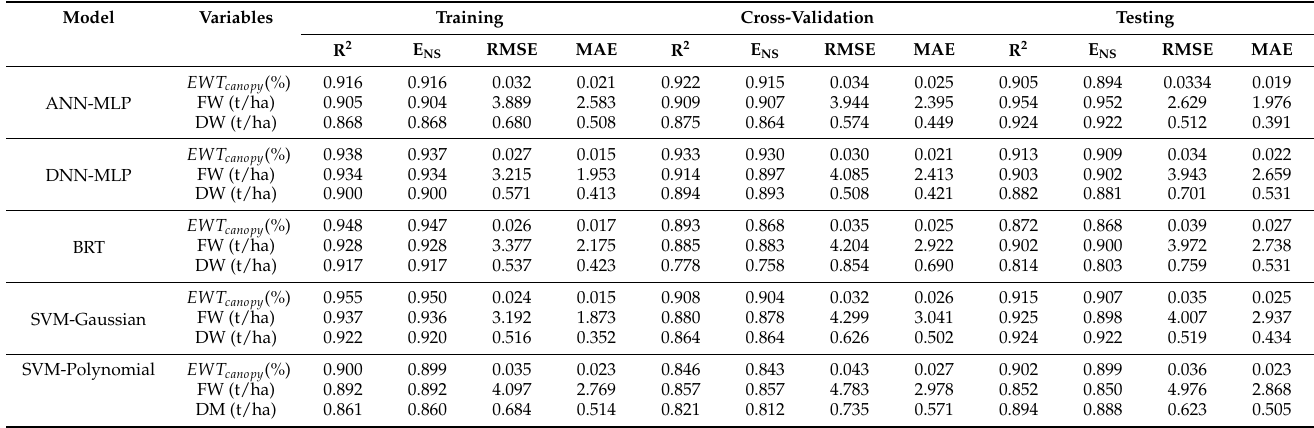
Table 7. Statistical performance indices of different machine learning (ML) algorithm during the training, validation, and testing stages for EWT canopy , FW, and